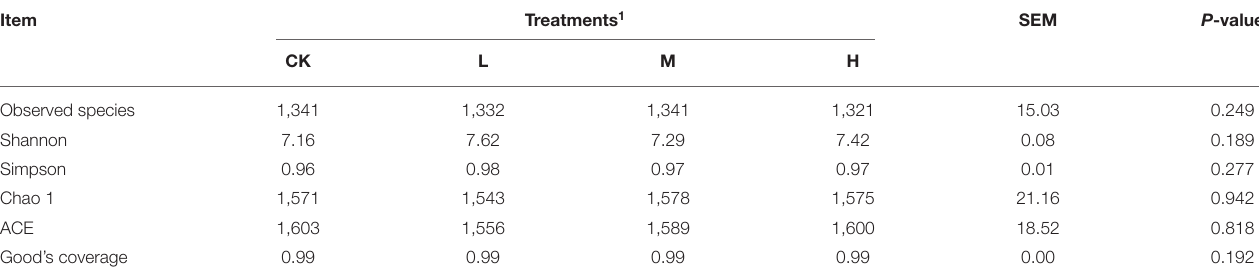
TABLE 3 | Operational taxonomic unit count and diversity estimation from sequencing analysis and based on the 16S rRNA gene libraries.